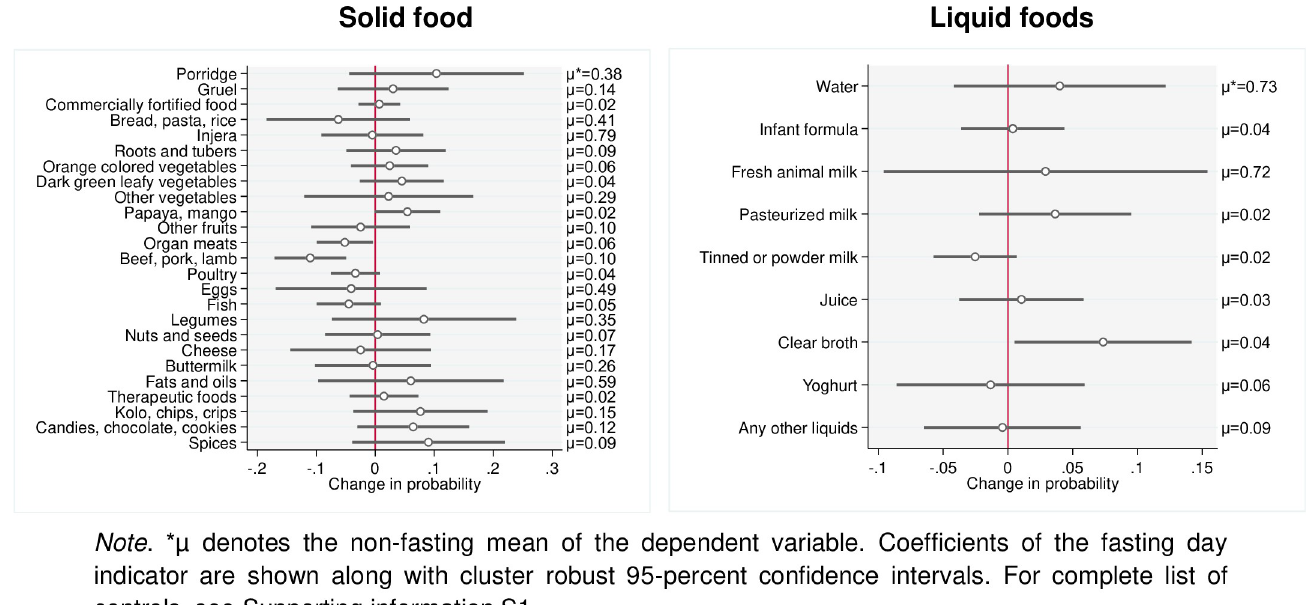
Fig 3. Impact of a fasting day on the likelihood of daily consumption of different food groups for the youngest